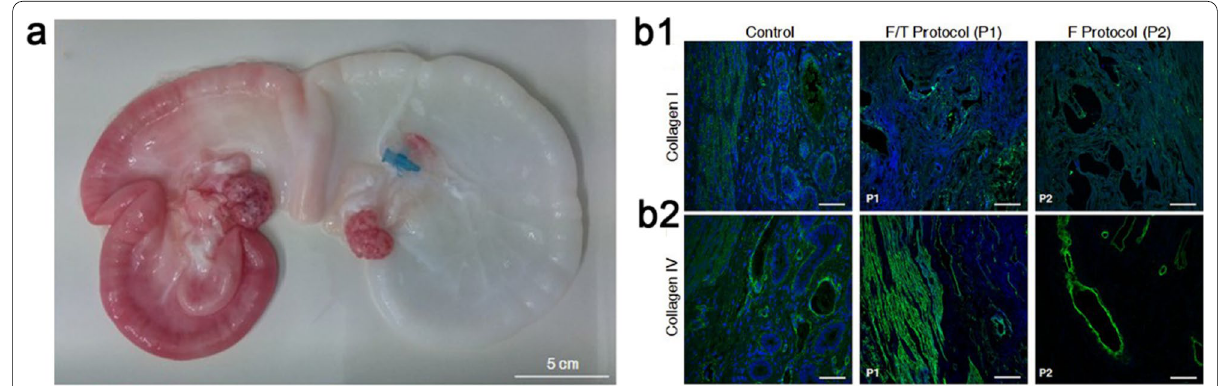
Fig. 6 dECM of porcine uterus. a Macroscopic picture of porcine uterine horns after decellularization (DC). b1, b2 Immunofluorescence staining of collagen I (green signal of b1 ) and collagen IV (green signal of b2 ) after DC. (Control: uterus before DC. P1: freeze/thawed samples after DC. P2: Fresh samples after DC). Reproduced with permission from